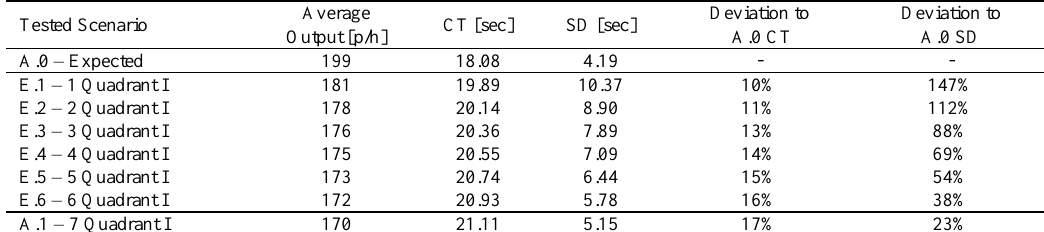
Table 8. Scenarios E simulation outputs compared to A.0 and